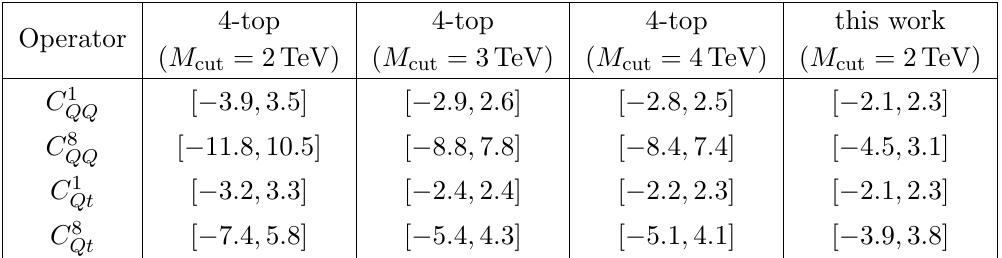
Table 1 . Projected individual con(cid:12)dence intervals quoted in ref. [34] from 4-top production. These are derived assuming an upper limit of the signal strength, (cid:22) < 1 : 87 is obtainable at the LHC with 300 fb (cid:0) 1 , as estimated in ref. [39]. The limits are reported as a function of an upper bound on the total invariant mass of the events, M cut . The last column compares these intervals to best projections from t (cid:22) tb (cid:22) b production obtained in our